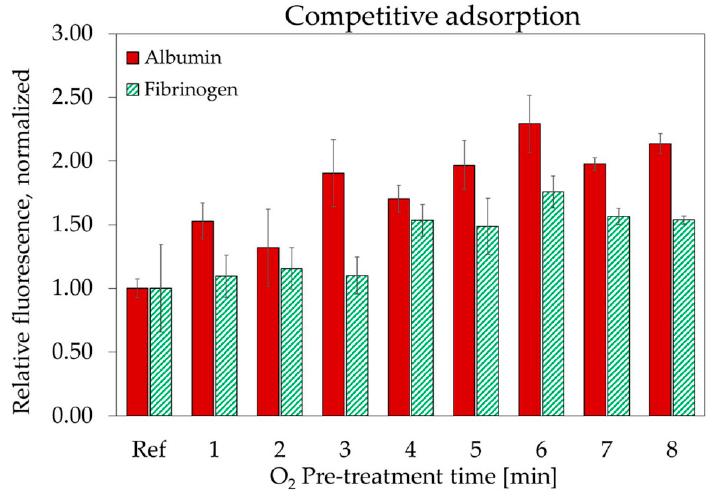
Figure 9. Competitive adsorption of albumin and fibrinogen on nanostructured Parylene-C surfaces in function of the O 2 plasma pre-treatment time. All measurements are normalized to the adsorption measured, for each protein, on untreated Parylene-C. The error bars represent the standard deviation between three different measurements.